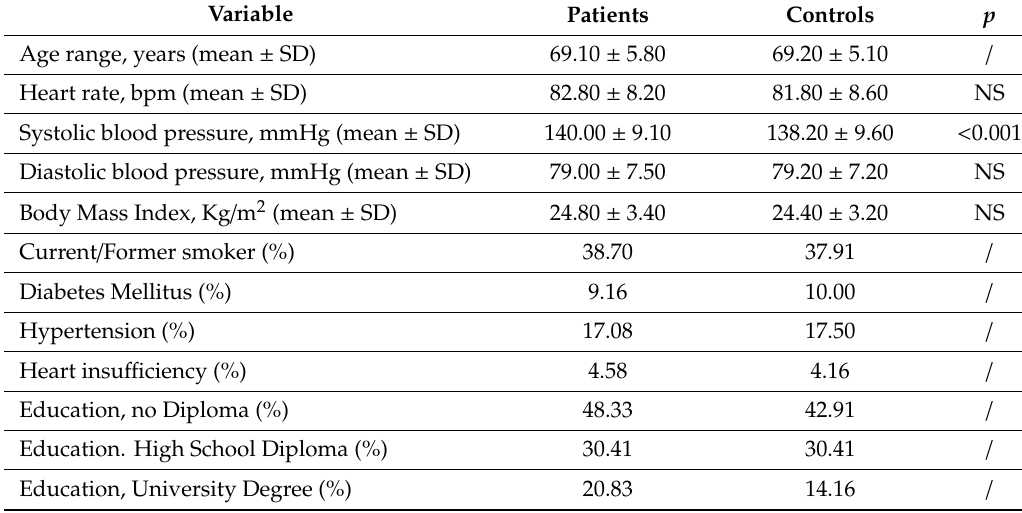
Table 1. Patients’ baseline